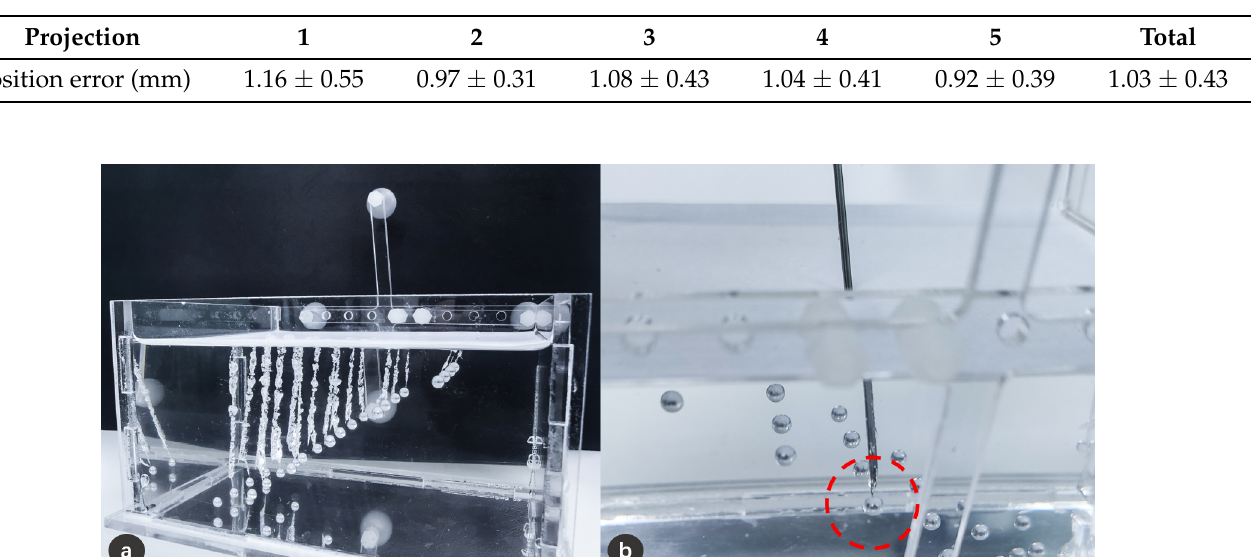
Table 1. Projection errors in position of the experiment results.